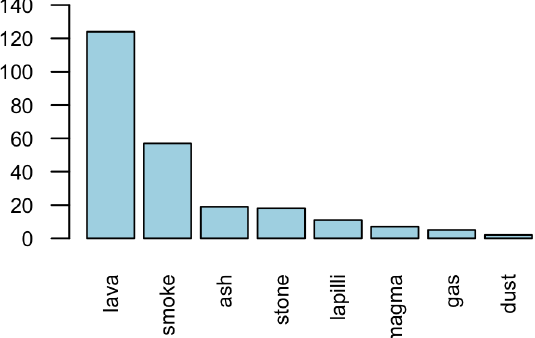
Figure 3. Frequencies of words used in the description of volcanic products. The corresponding Italian terms are as follows: lava – lava; smoke – fumo; ash – cenere; stone – pietra; lapilli – lapilli; magma – magma; gas – gas; and dust – polvere. Both singular and plural terms are always